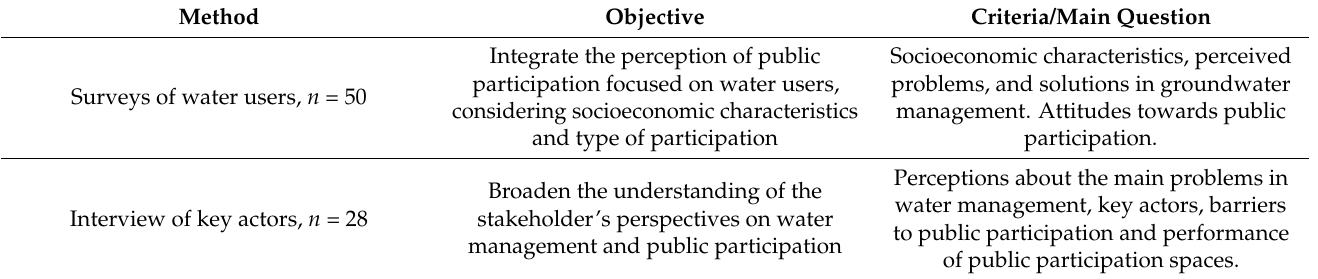
Table 1. Mixed method used to inquire about public participation in groundwater management. Method Objective Criteria/Main Question Integrate the perception of public Socioeconomic characteristics, perceived participation focused on water users, problems, and solutions in groundwater Surveys of water users, n = 50 management. Attitudes towards public considering socioeconomic characteristics participation. and type of participation Perceptions about the main problems in Broaden the understanding of the water management, key actors, barriers Interview of key actors, n = 28 stakeholder’s perspectives on water to public participation and performance management and public participation of public participation